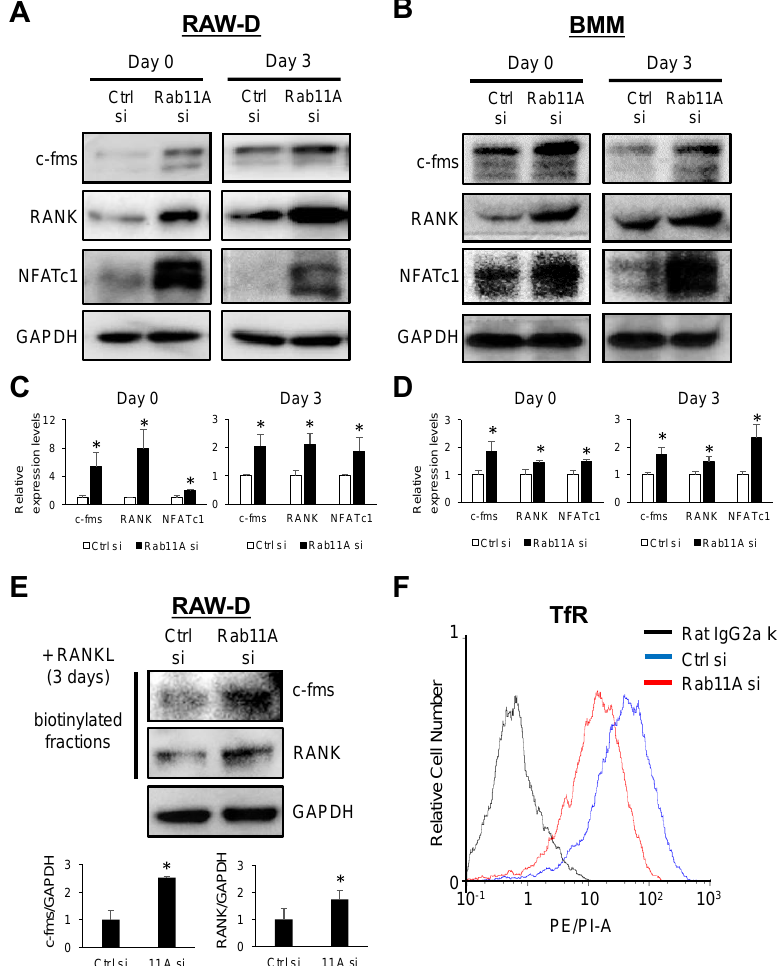
Figure 6. The e ff ects of Rab11A silencing on cell surface levels of c-fms and RANK receptors in RAW-D cells stimulated with RANKL (300 ng / mL). ( A ) The endogenous levels of c-fms, RANK, and NFATc1 in Ctrl or Rab11A si-treated RAW-D cells stimulated with RANKL for 0 (left panels) or 3 days (right panels). ( B ) The endogenous levels of c-fms, RANK and NFATc1 in Ctrl or Rab11A si-treated BMMs stimulated with RANKL for 0 (left panels) or 3 days (right panels). ( C , D ) Quantitative analyses of Western blot for c-fms, RANK, NFATc1, in RAW-D cells ( C ) or BMMs ( D ). GAPDH was used as an internal control. * p < 0.05. ( E ) Upper: The biotinylated fractions were subjected to